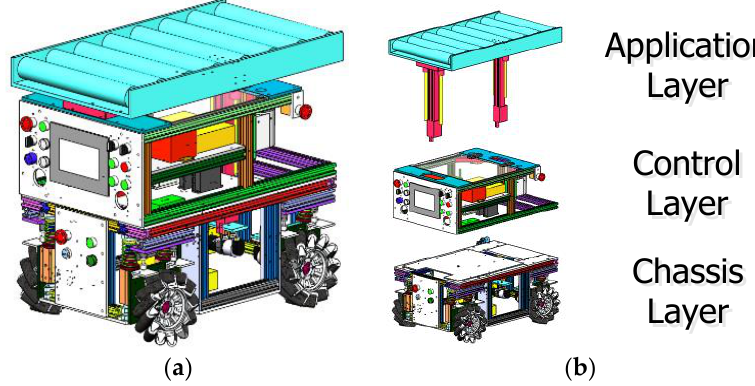
Figure 3. The mechanical components of the robot body. ( a ) 3D model of the mobile body; ( b ) three independent layers. Table 1. General specifications of RedwallBot-1.